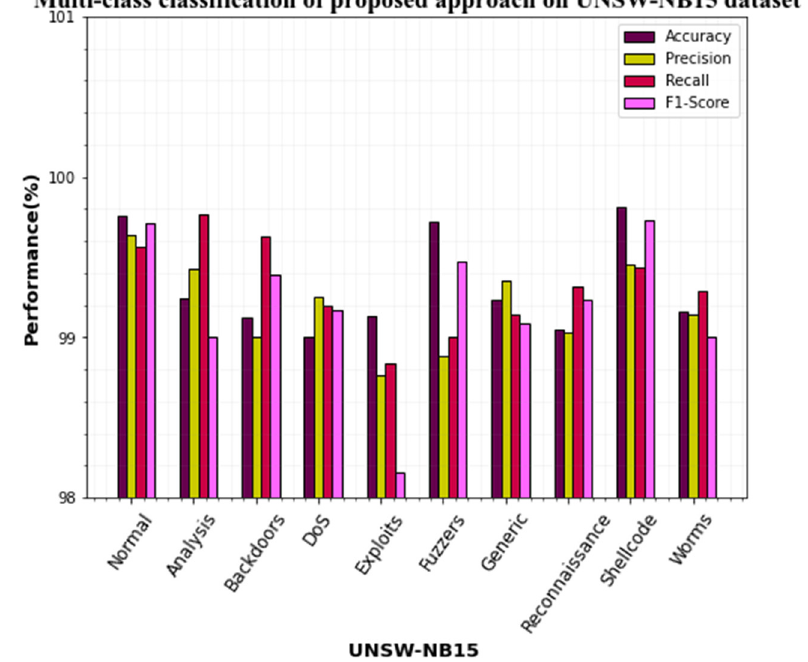
Figure 6. Multiclass classification performances on the UNSW-NB15 dataset.